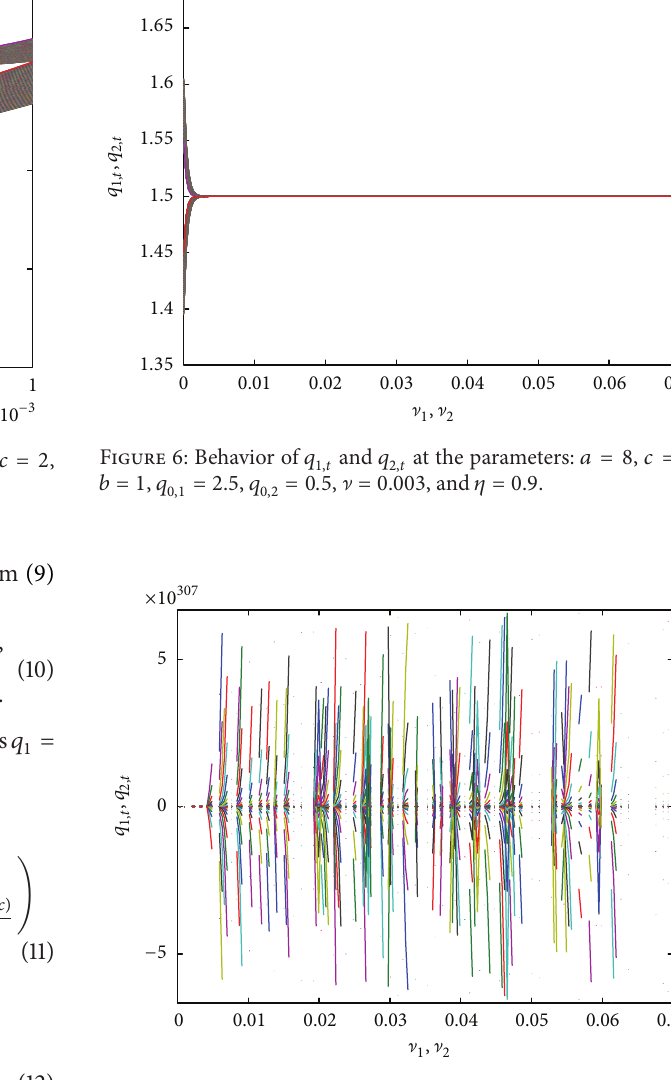
Figure 7: Behavior of 𝑞 1,𝑡 and 𝑞 2,𝑡 at the parameters: 𝑎 = 8 , 𝑐 = 2 , = 2.5 , 𝑞 = 0.5 , ] = 3 , and 𝜂 = 1 𝑏 = 1 , 𝑞 0,1 0,2